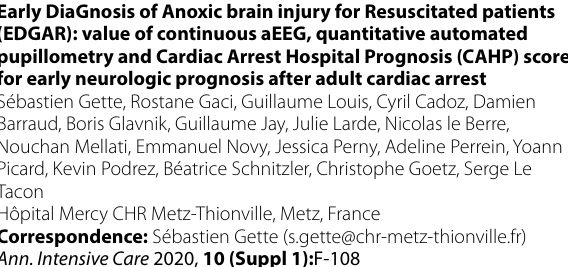
Fig. 1 Stepwise model for early